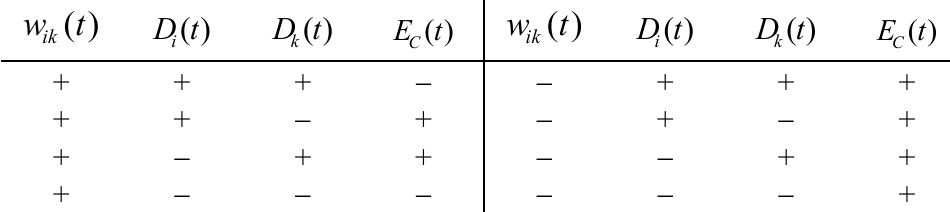
Table 1. Behavior of the energy term against data and contextual